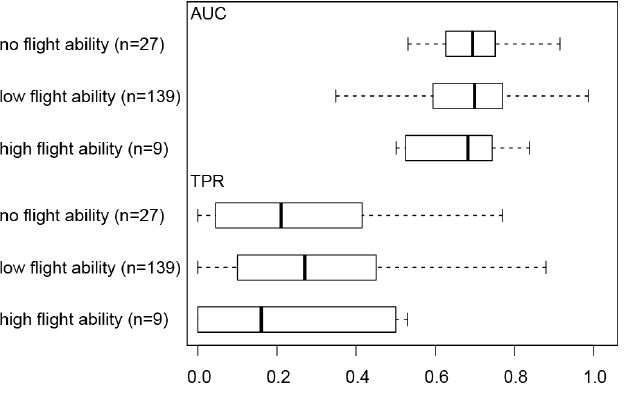
Figure 3. Boxplot of model accuracy (AUC and TPR) per taxon grouped according to their flight ability. No significant differences in mean values between the groups were found ( t -test; p >